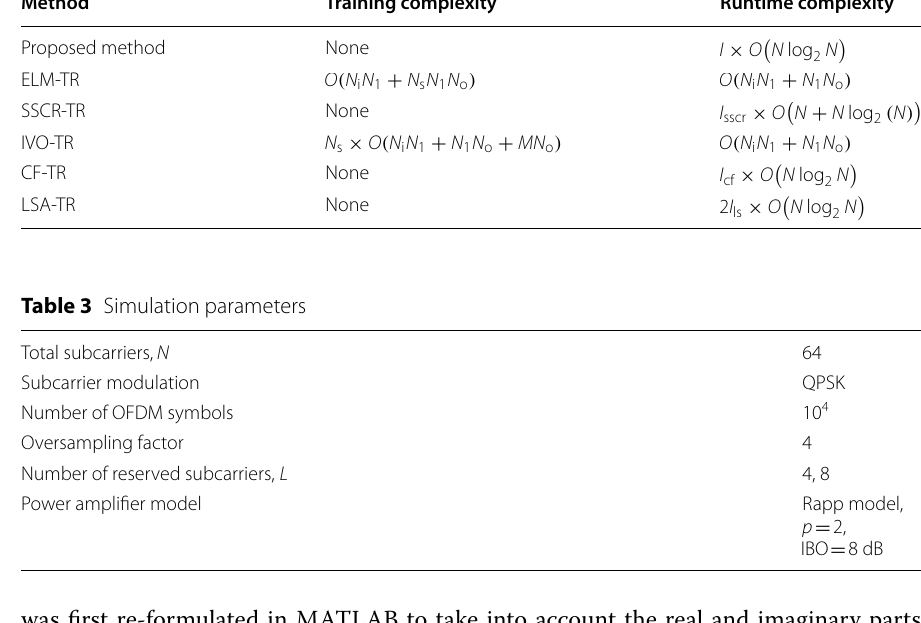
Table 2 Computational complexity comparison Method Training complexity Runtime complexity Proposed method